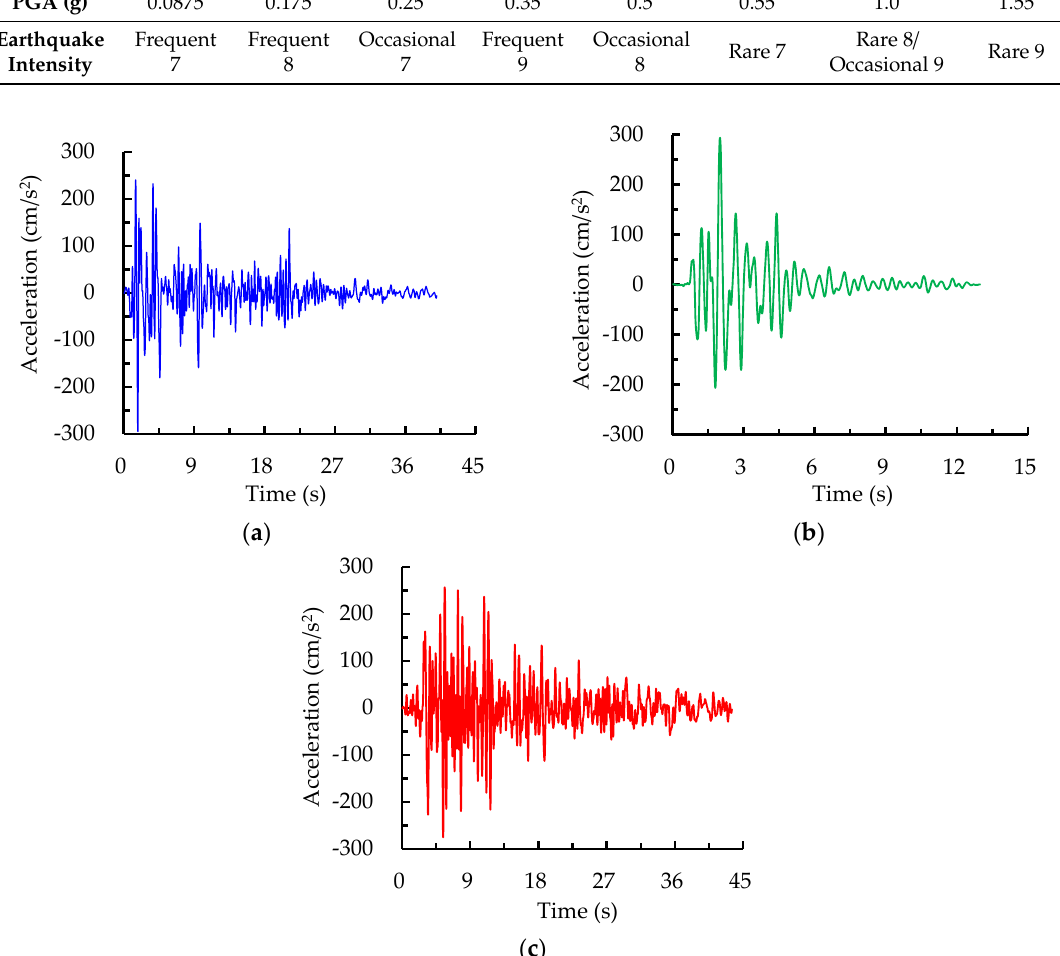
Figure 14. Loading earthquake waves. ( a ) El Centro wave; ( b ) Kobe wave; ( c ) Taft wave.